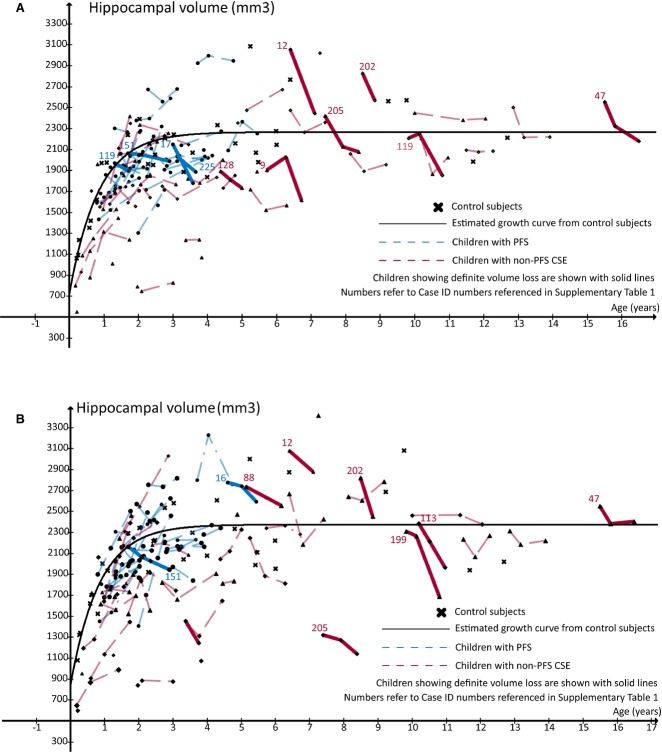
Left (A) and right (B) hippocampal growth in the year following CSE. Children showing definite hippocampal volume loss are shown with solid lines.